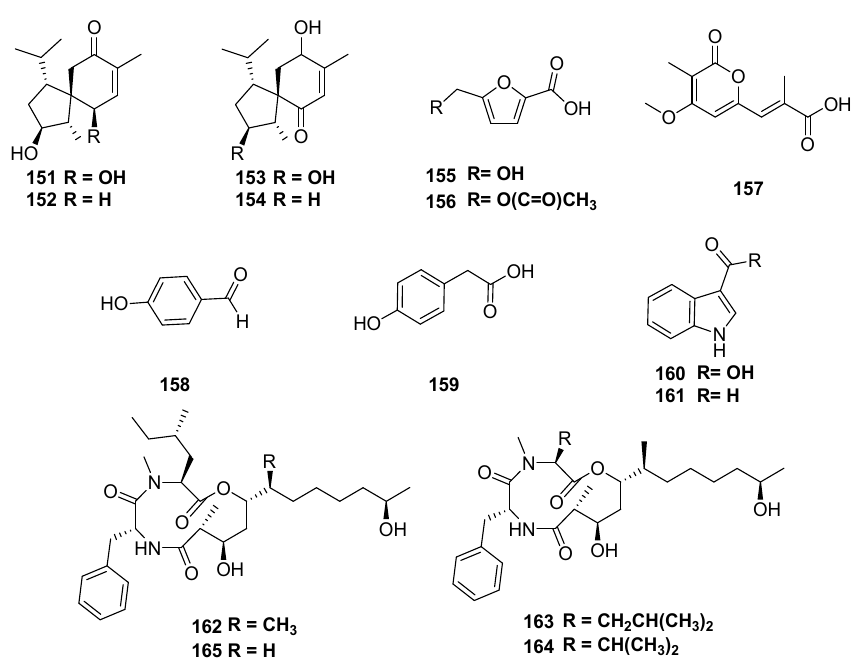
Figure 12 . Compounds extracted from endophytic fungi, Colletricnhum sp. obtained from Sabicea cinereal and Rubia pondantha . J. Fungi 2020 , 6 , x FOR PEER REVIEW